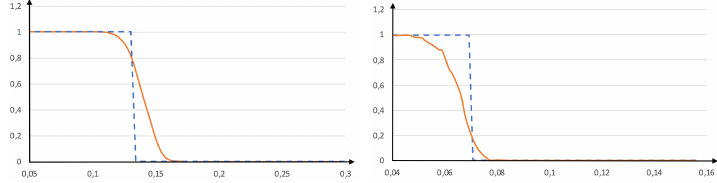
Figure 3. P 2 versus P 3 for the Runge function with α = 25 (left) and α = 2000 (right). Statistical frequencies (full) and probabilistic law (2.5) (dotted). 500 meshes are used for each value of h .